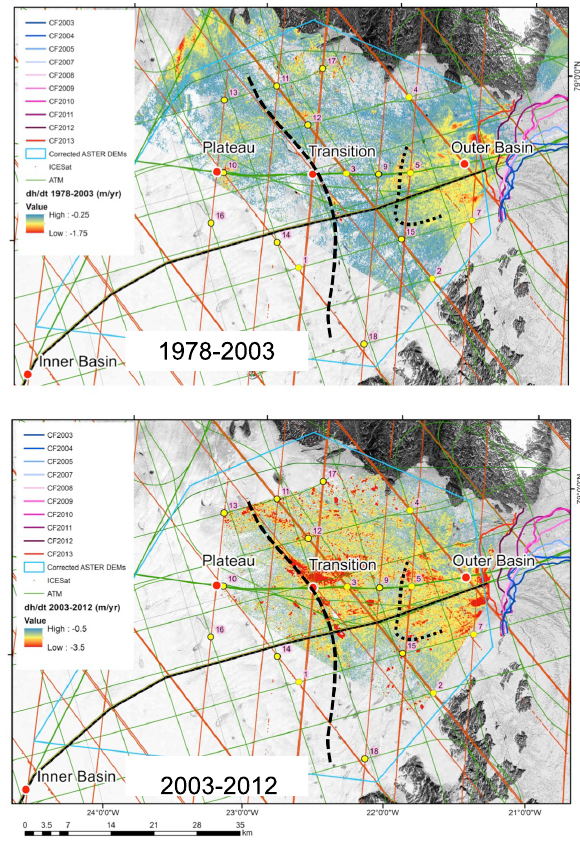
Figure 8. Upper panel: elevation change between 1978 (aerial photogrammetry DEM) and 2003 (corrected ASTER DEM). Lower panel: elevation change between 2003 and 2012 (both corrected ASTER DEMs). Warm, red colors indicate largest thin- ning. Colored lines mark calving front positions and dashed black lines indicate large changes in bedrock